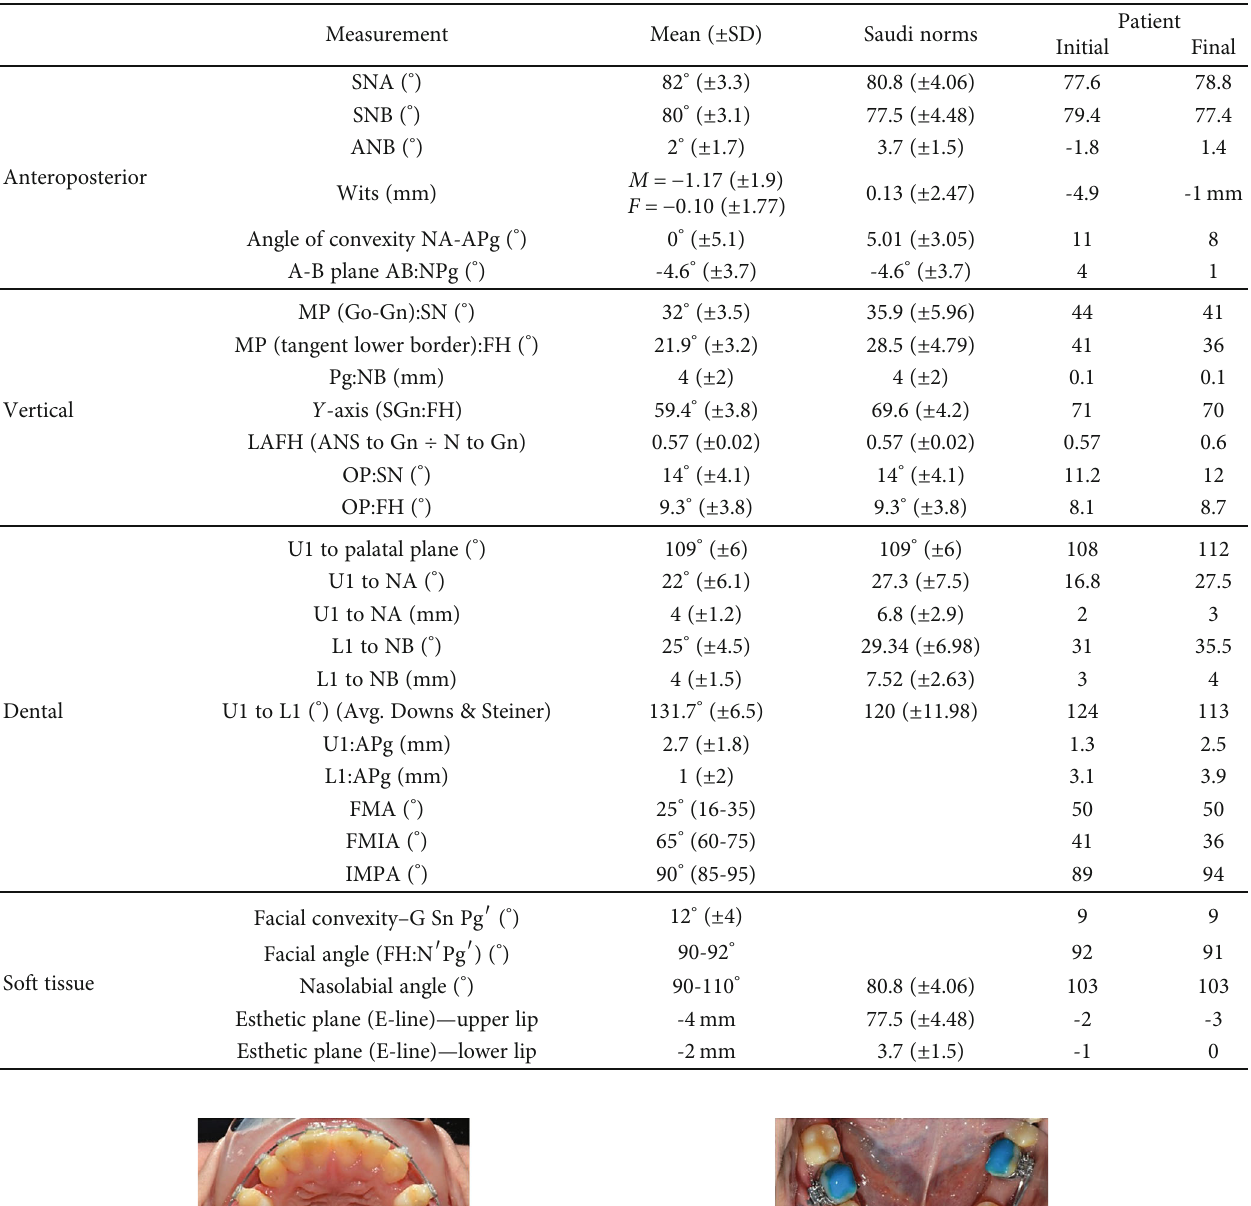
Table 1: Pre- and posttreatment cephalometric measurements.